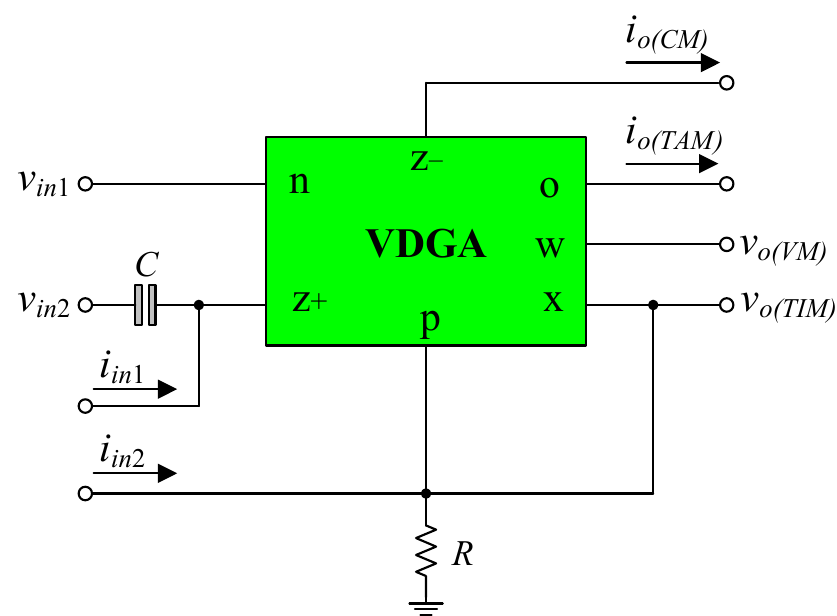
Figure 2. Proposed mixed-mode first-order universal filter.